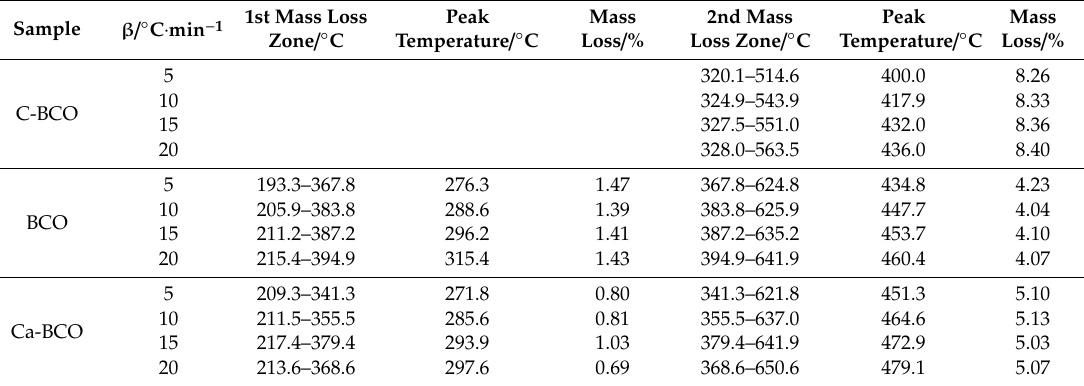
Table 1. Thermogravimetric (TG) results of the samples obtained from di ff erent heating rates.